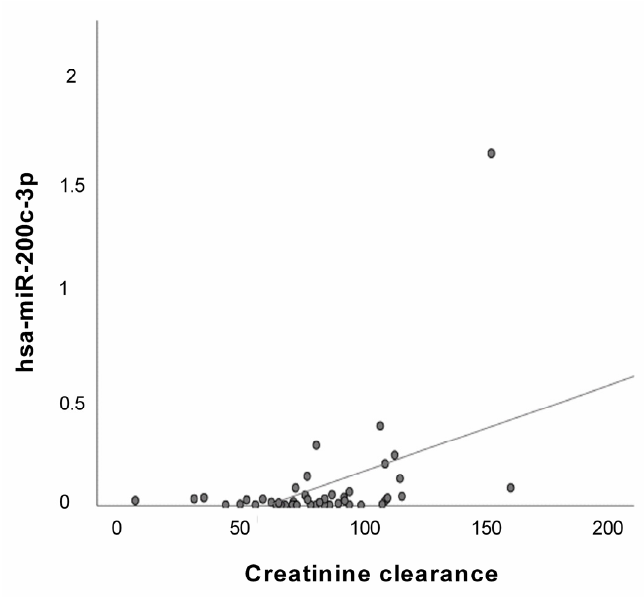
Figure 8. Correlation analysis of has-miR-200c-3p in the CAD group. Scatter plots depict the relationship among hsa-miR-200c-3p and creatinine clearance values in the CAD group (R 2 = 0.212, p < 0.005, Pearson r = 0.461).